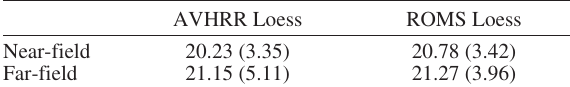
Table 1. – SST (°C) sample means and variances (in parenthesis) for the Loess-smoothed AVHRR and ROMS SST time series at the near- and far-field stations shown in Figure 3. See Figure 3D for the locations of the two